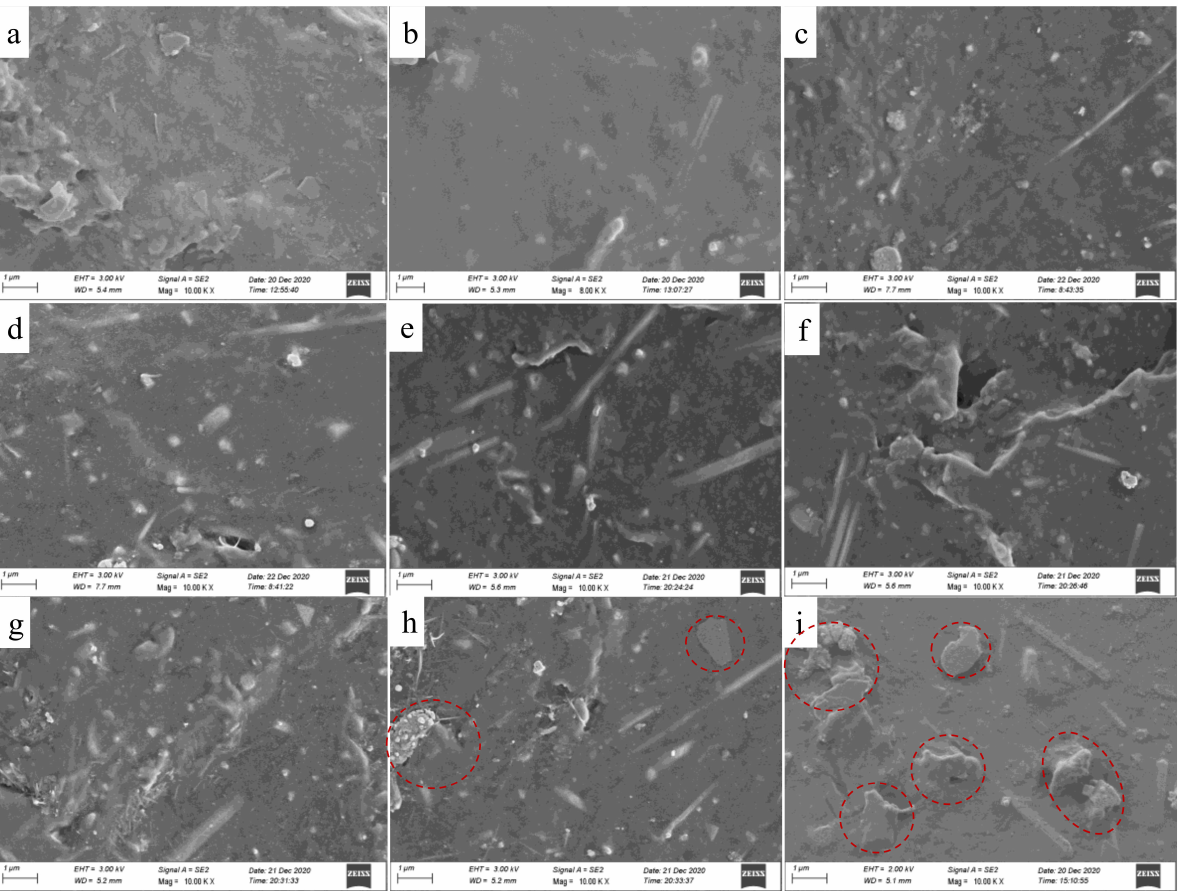
Figure 6. SEM images of cross-section morphology of the composite films with the AgNWs-RGO mass contents of 0 wt% ( a ), 5 wt% ( b ), 10 wt% ( c ), 15 wt% ( d ), 20 wt% ( e ), 25 wt% ( f ), 30 wt% ( g ), 35 wt% ( h ), and 37 wt% ( i